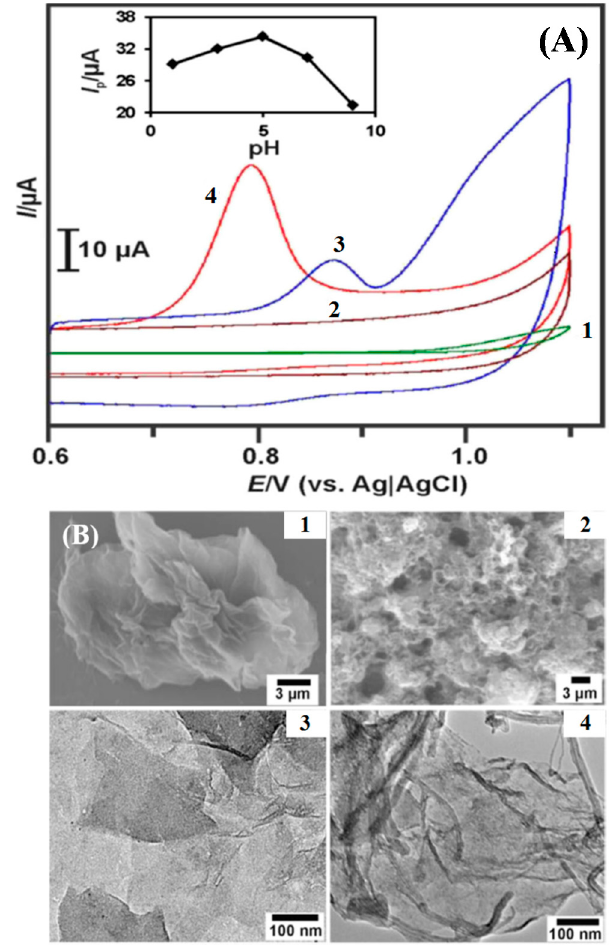
Figure 1. ( A ) Cyclic voltammograms (CVs) obtained at bare (1) GCE, (2) GO/GCE, (3) MWCNTs/GCE, and (4) GO–MWCNT/GCE for 1.0 mmol · L − 1 diuron in 0.1 mol · L − 1 phosphate buffer (pH 5) solution at a scan rate of 50 mV s − 1 . Inset: plot of I p versus pH from CVs obtained at GO–MWCNTs/GCE. ( B ) SEM images of GO (1) and GO–MWCNTs (2). TEM images of GO (3) and GO–MWCNTs (4). (Reproduced with permission of Springer from [87]).